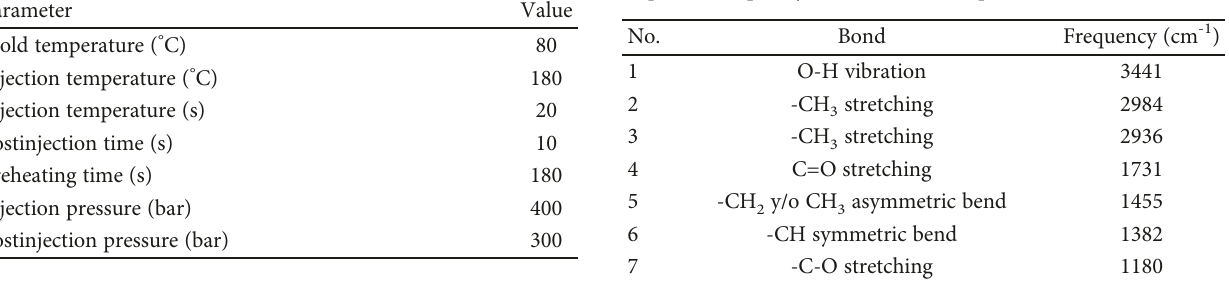
Table 5: Assignment of bands to functional groups with their respective frequency in medium FTIR spectra [9 –